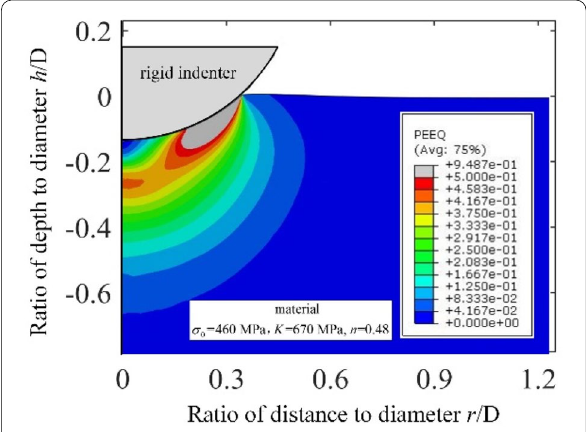
Figure 9 The distribution of equivalent plastic